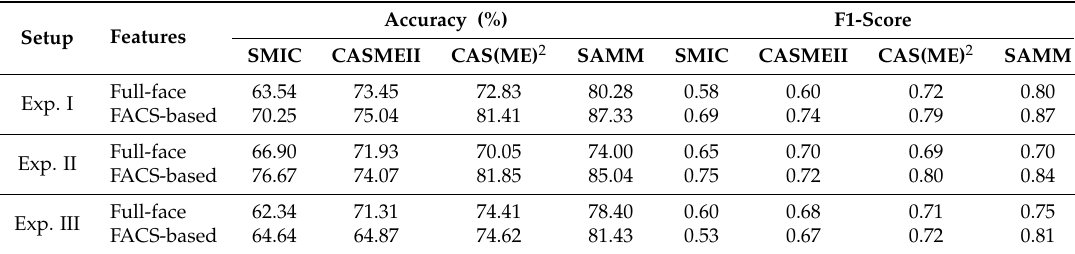
Table 6. Experimental Results (Accuracy & F1-score) for leave-one-subject out cross validation